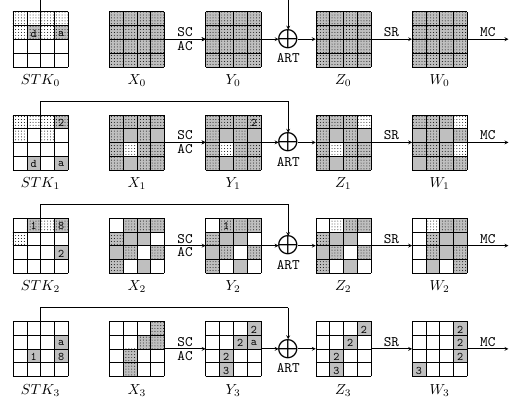
Figure 5: Phase (1): The N b -round of the attack on SKINNY-64-192 . In Phase (1) shown in Fig. 5, in order to compute Y 3 [3 , 6 , 7 , 9 , 13] from P 1 , we need the values of the cells marked by in X . With the details of MC and SR , the values of the 3 cells marked by and in Z and corresponding STK are needed. The cell positions 2 2 and and